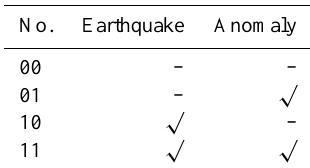
Table 2. Four categories of the relationship between earthquake and